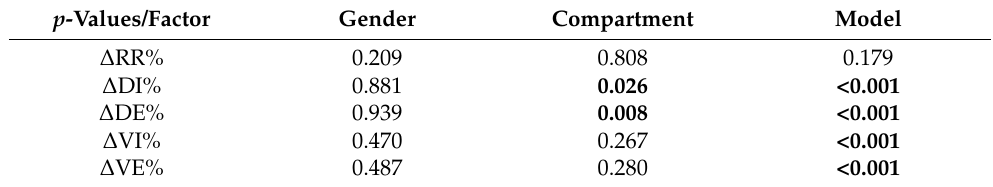
Table 6. Outcomes of three-way ANOVA for the analysis of gender (2 levels: female and male), compartment (3 levels: CW, RC, and AB), and model (2 levels: Model 1 and Model 2) on the relative error percentage of respiratory parameters assessed with IMU-based models (data reported in Figure 7). The p -values are highlighted in bold when reaching significance ( p < 0.05). ∆ DE% = − 13.0 ± 7.6; AB: ∆ DI% = 14.4 ± 8.7; and ∆ DE% = − 11.6 ± 6.7) were typically p -Values/Factor Gender Compartment Model Δ RR% 0.209 0.808 0.179 ∆ DI% = 4.5 ± 10.4; ∆ DE% = − 4.2 ± 10.4; AB: ∆ DI% = − 0.8 ± 5.1; and ∆ DE% = 0.6 ±